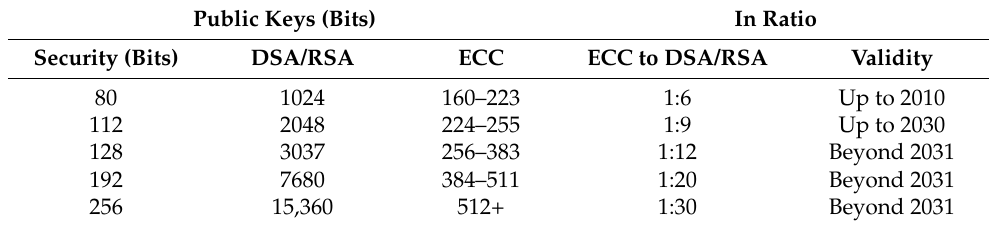
Table 3. Key size comparison of DSA/RSA and ECC.